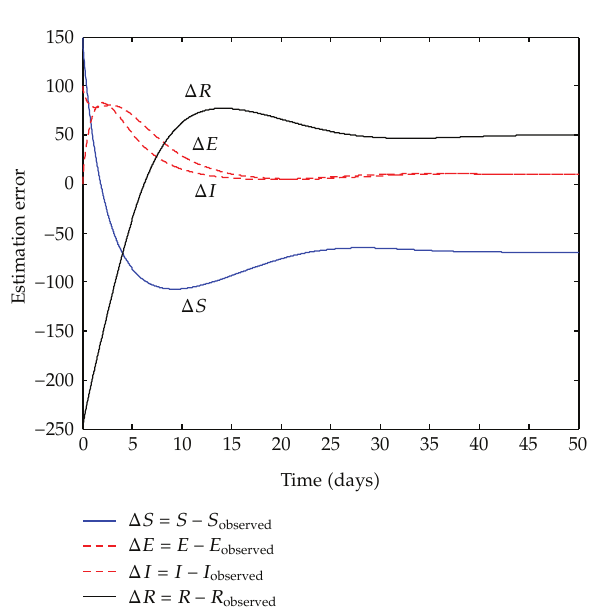
Figure 4: Observation error in the vaccination-free case and unknown model parameters.